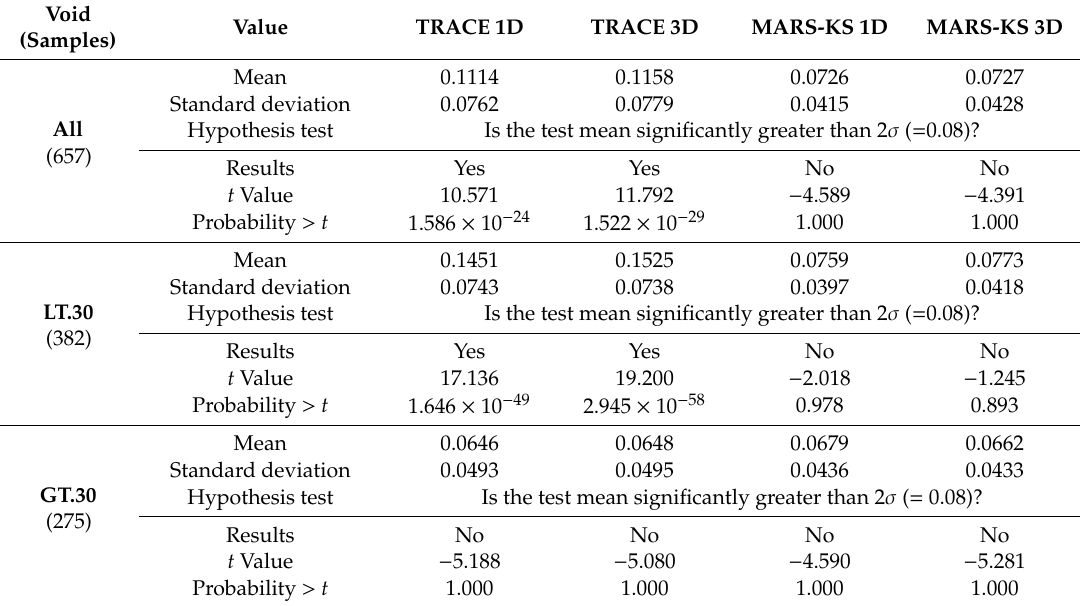
Figure 7. Code comparisons: ( a ) 1D void predictions; ( b ) 3D void predictions. Table 3. Results of one-sample t -test for assessing code predictions.